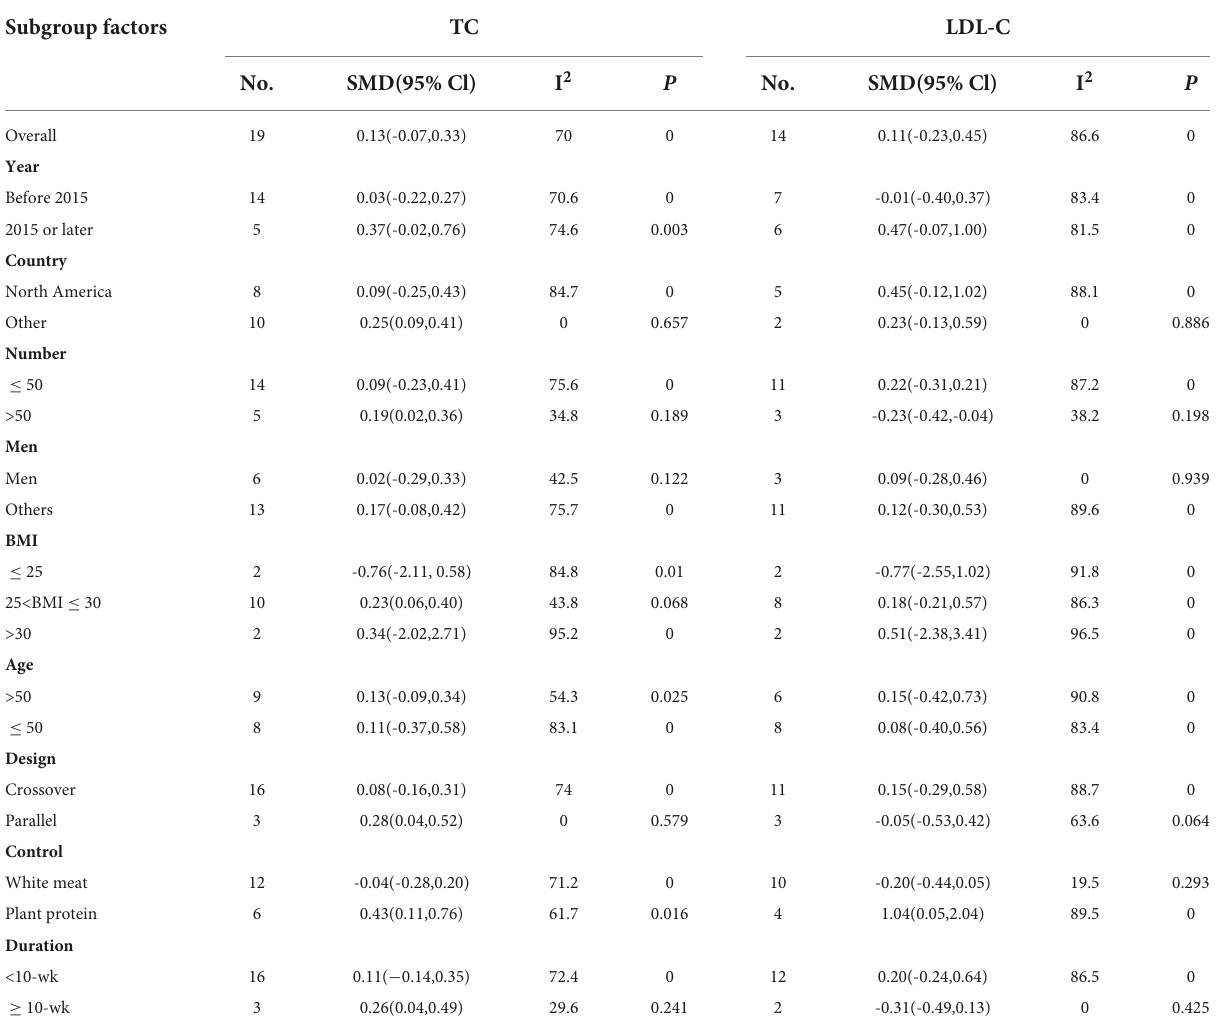
TABLE 6 Subgroup analyses for TC, LDL-C